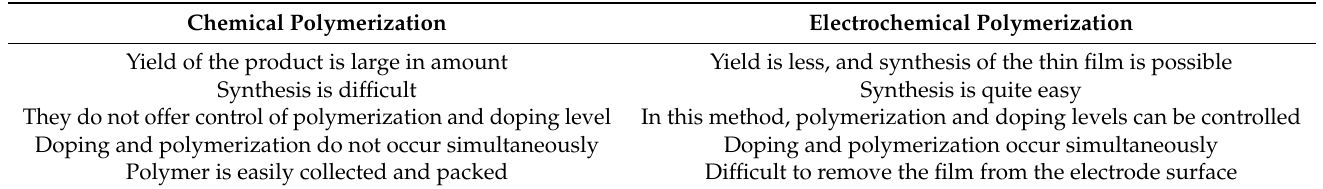
Table 2. Comparison of Chemical and Electrochemical Polymerization.